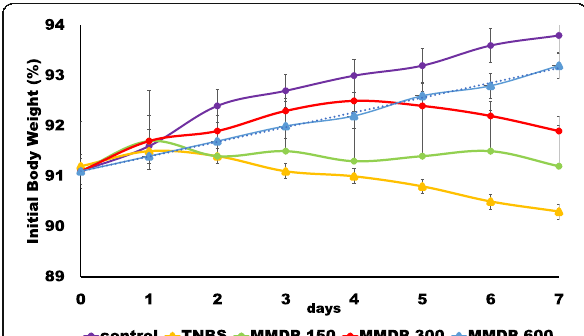
Fig. 2 Mango Mistletoe Dendrophthoe pentandra (MMDP) extract protects against trinitrobenzene sulfonic acid (TNBS)-induced colitis. Mice with TNBS-induced colitis were treated with MMDP extract (150, 300, and 600 mg/kg). Change in body weight was monitored for 7 days. The changes (percentage of original body weight) have been plotted. Results represent the mean ± SD from 6 mice per group. ∗ p < 0.05, ∗∗ p <